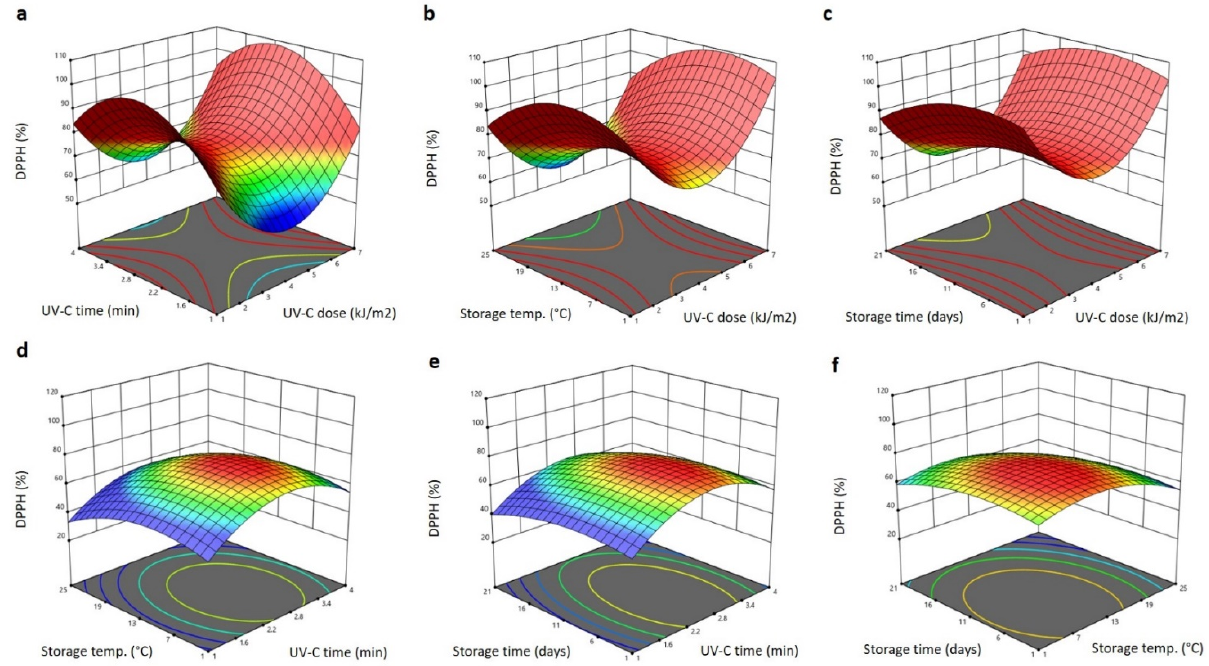
Figure 7. Response surface plots of DPPH antiradical activity of Barhi dates as a function of UV-C time and UV-C dose ( a ), storage temperature and UV-C dose ( b ), storage time and UV-C dose ( c ), storage temperature and UV-C time ( d ), storage time and UV-C time ( e ), and storage time and storage temperature ( f ).